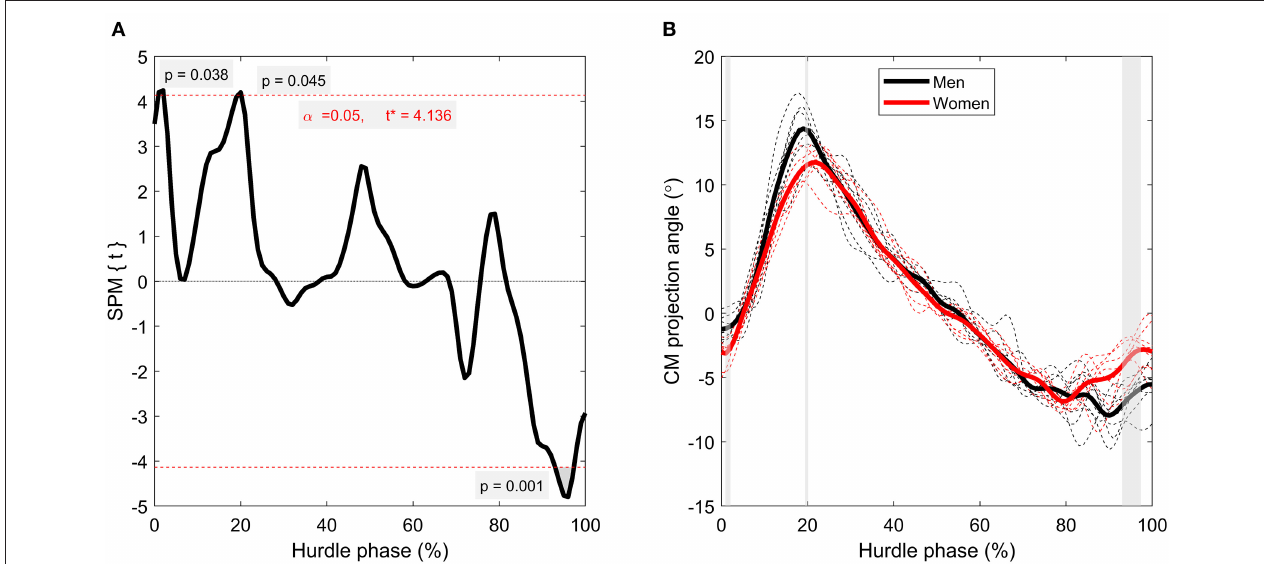
FIGURE 6 | Time-series comparison between men and women for CM angle of projection. The left-hand figure (A) contains the SPM t -statistic curve, and the right-hand figure (B) contains grouped mean curves (thicker, solid lines) as well as individual athlete data (thinner, dashed lines) for men (black lines) and women (red lines). Gray-shaded regions correspond with suprathreshold clusters detected through